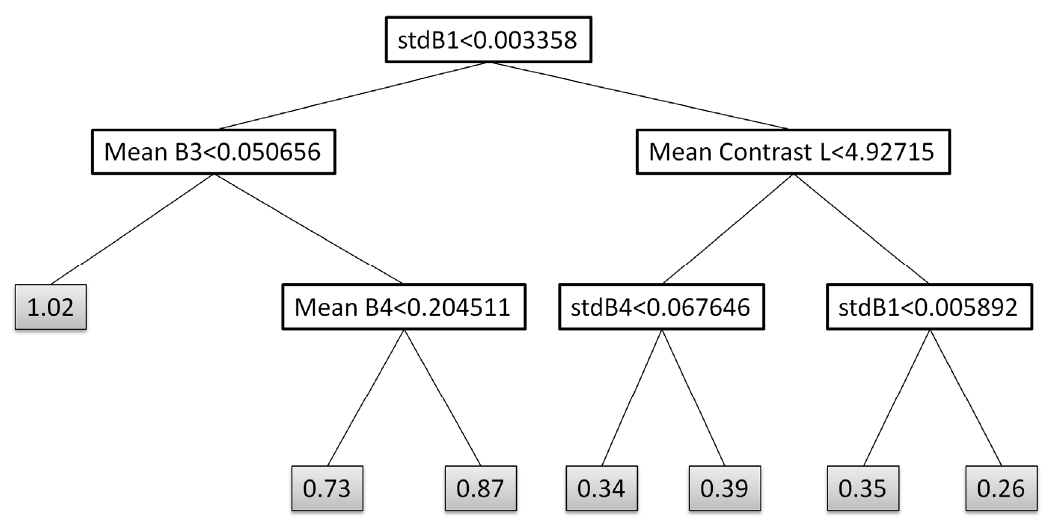
Figure 6. Example of a regression tree model of QMD. Hollow boxes represent branch rules; elements fulfilling the rule go to the left, the rest go to the right. Values of terminal nodes average QMD of elements in the group.